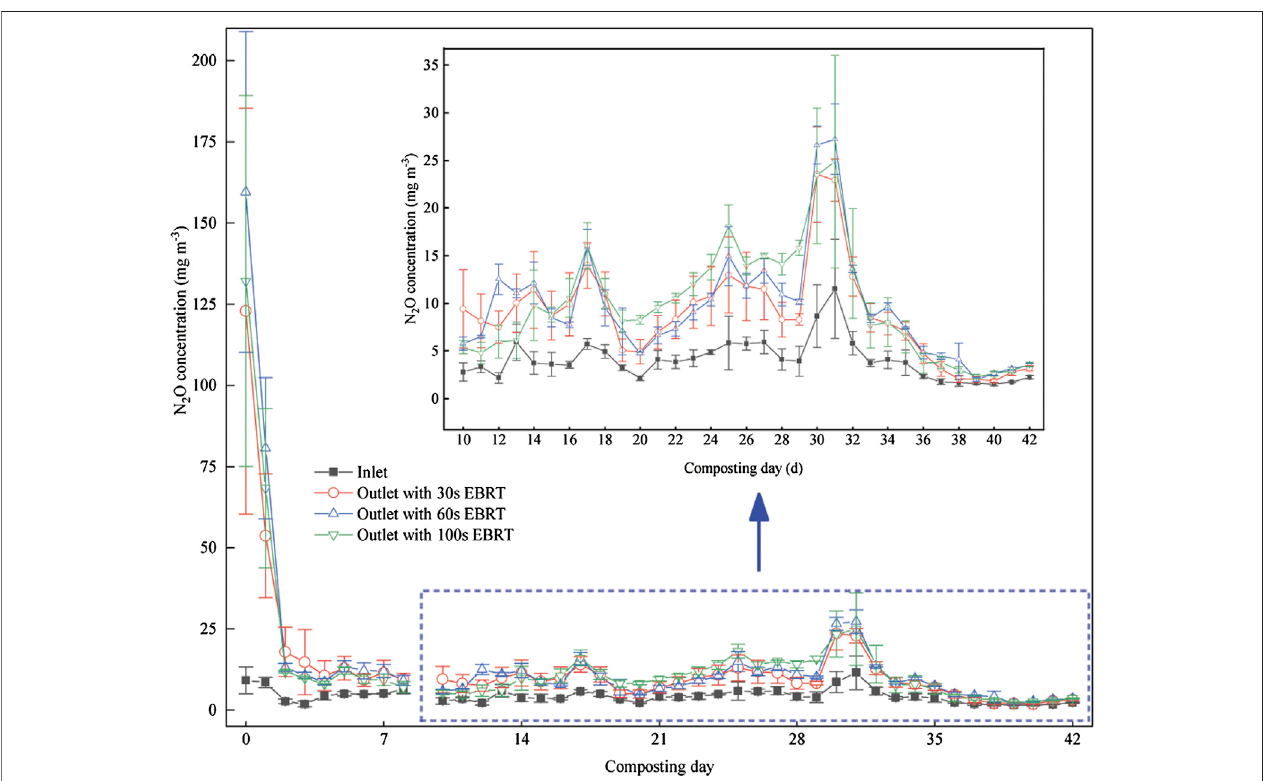
FIGURE 2 | Daily N 2 O concentrations (mean ± SE) at the bio fi lter inlet (IC) and outlet (OC).